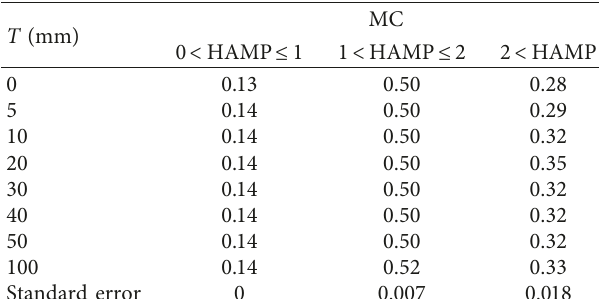
Table 3: MC of different size outliers at Wuyigong Station.